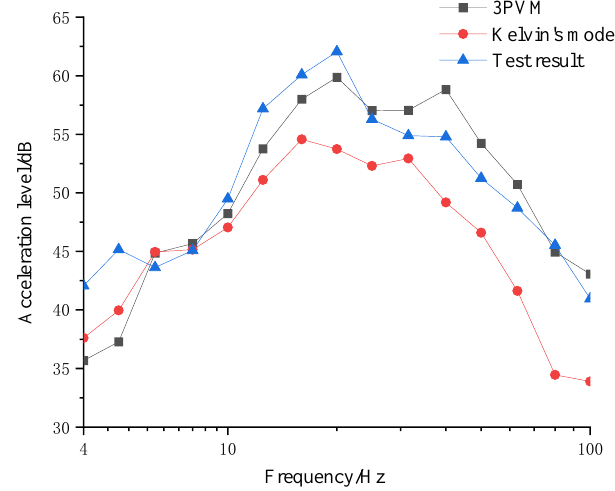
Figure 14. Comparison of measured and calculated 1/3 octave. Overall, Kelvin’s model result underestimates the test result at any frequency. The average error of Kelvin’s model is 5 dB, and the max error is 11 dB at 80 Hz. Compared with the test result, the 3PVM result is sometimes larger and sometimes smaller with the change of frequency. However, the average error and the max error of the 3PVM are both smaller than in Kelvin’s model.